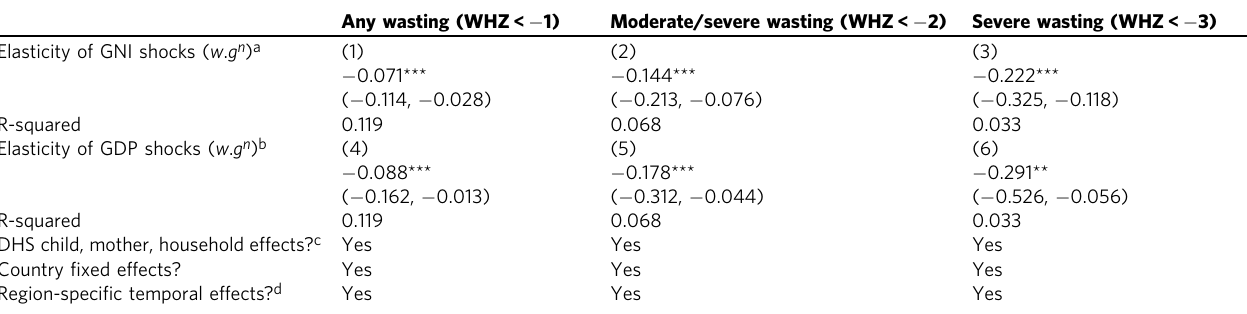
Table 1 Weighted multivariate linear probability models of wasting risks as a function of lagged annual change in GNI per capita or GDP per capita (children 0 – 59 months).